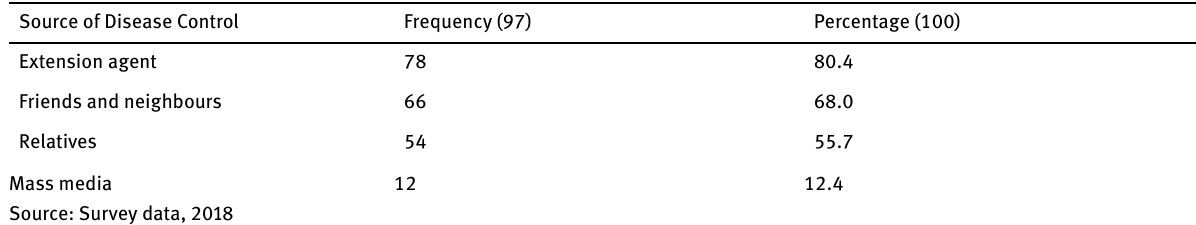
Table 7: Sources of information of cassava farmers Source of Disease Control